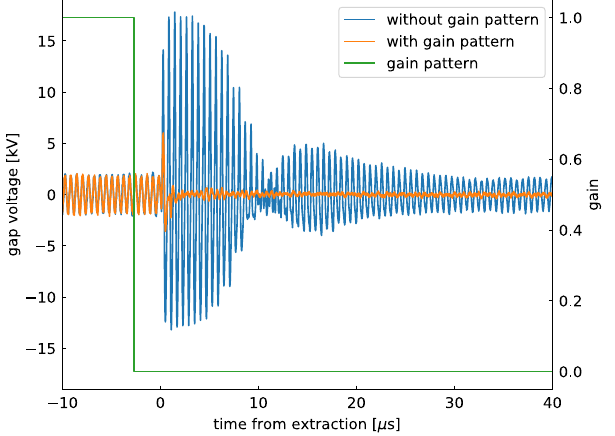
FIG. 37. Voltage waveforms near the extraction of a 1 MW equivalent beam without and with the gain pattern. The applied gain pattern is also